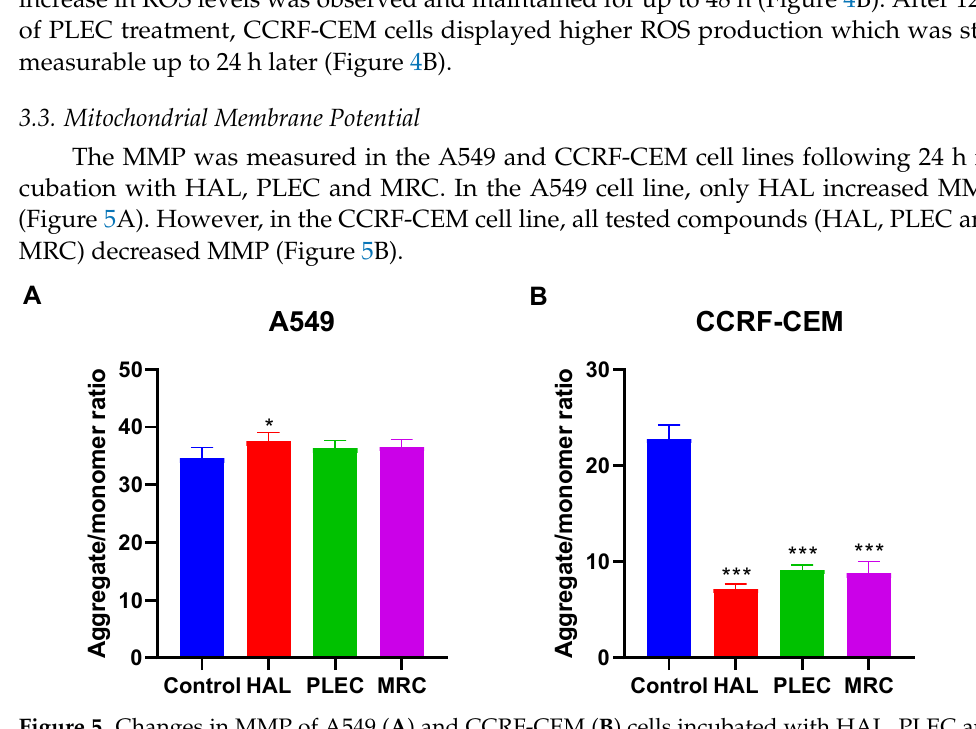
Figure 4. Formation of reactive oxygen species (ROS) in A549 ( A ) and CCRF-CEM ( B ) cells treated with HAL, PLEC and MRC for 1, 2, 12, 24 and 48 h. The results represent means ± SD. * p < 0.05, ** p < 0.01, *** p < 0.001 vs. control cells.